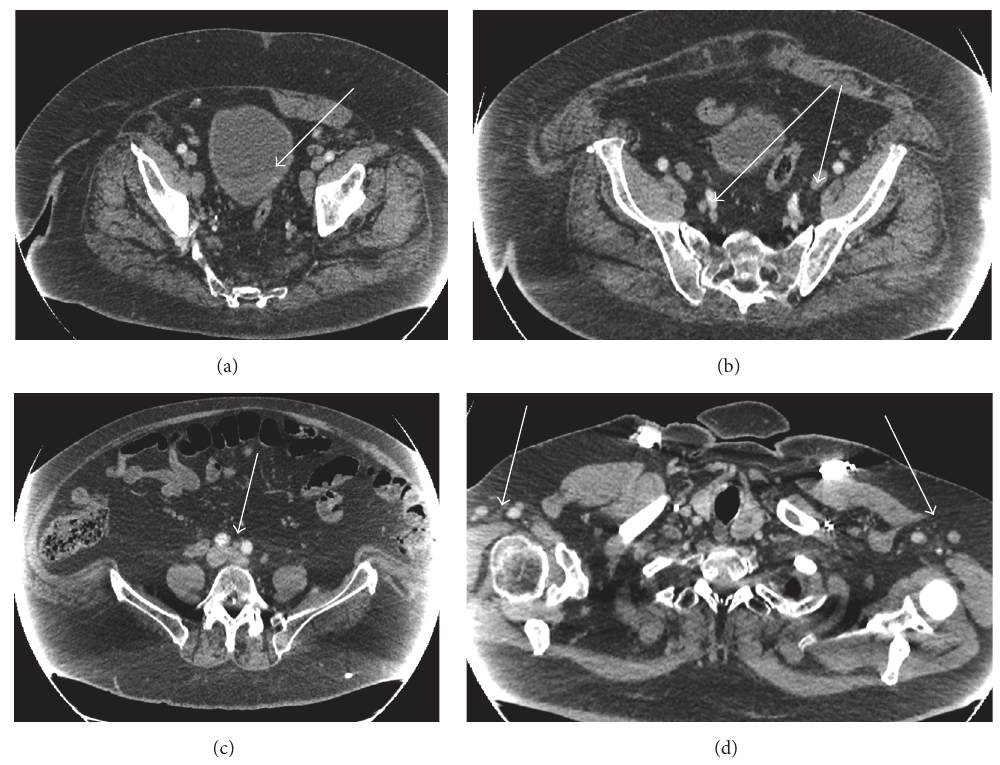
Figure 2: (a) Bladder mass, after chemotherapy. (b) Pelvic lymphadenopathy, after chemotherapy. (c) Retroperitoneal lymph node above aortic bifurcation, after chemotherapy. (d) Axillary lymph nodes, after chemotherapy.